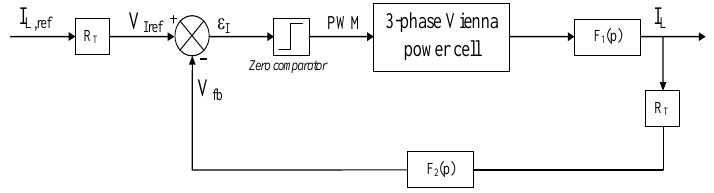
Figure 2. PSSOCC current control technique synoptic per phase.